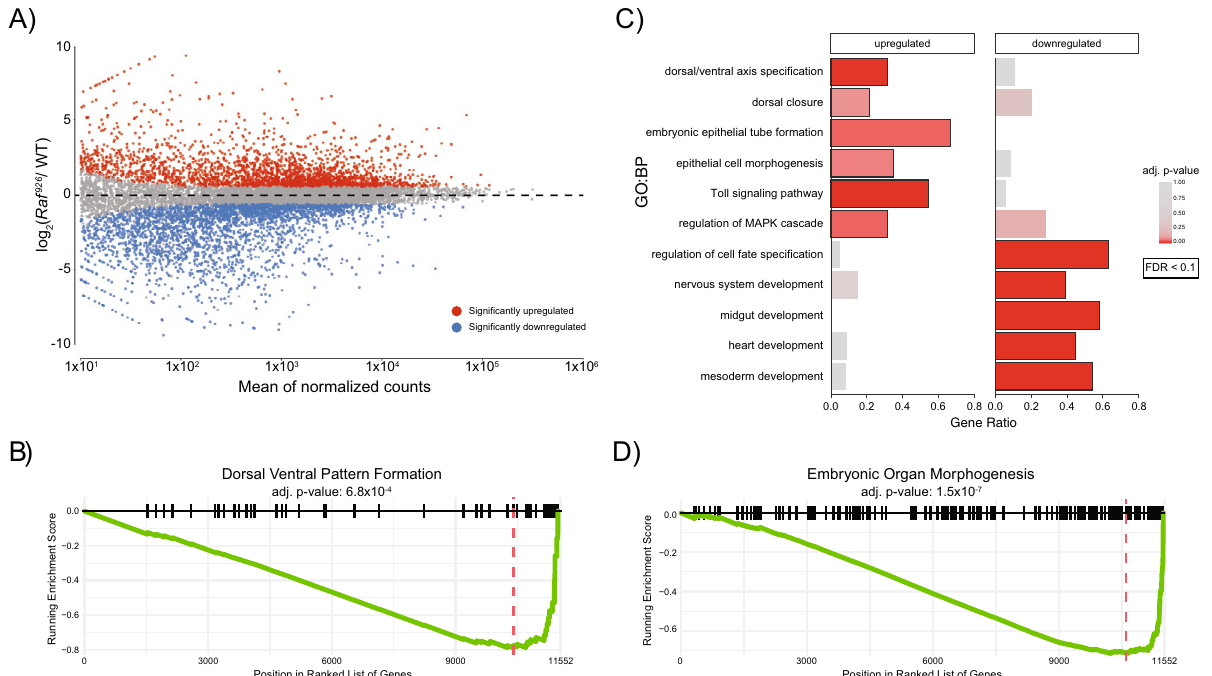
Figure 2. Transcriptional profiling of WT, Raf 926 embryos identifies significant differences in the expression of genes involved in Dorsal/Ventral patterning, organogenesis and the Toll pathway. ( A ) MA-plot shows a large number of genes are significantly differentially expressed between Raf 926 mutant and WT embryos (three biological replicates per condition). ( B ) GSEA identifies that genes annotated as involved in dorsal–ventral pattern formation are altered in Raf 926 mutants. ( C ) GO Biological Process (GO:BP) enrichment analysis identifies that the significant up- and downregulated genes are enriched for distinct processes. ( D ) GSEA identifies that genes are involved in embryonic organ morphogenesis and perturbed in Raf 926